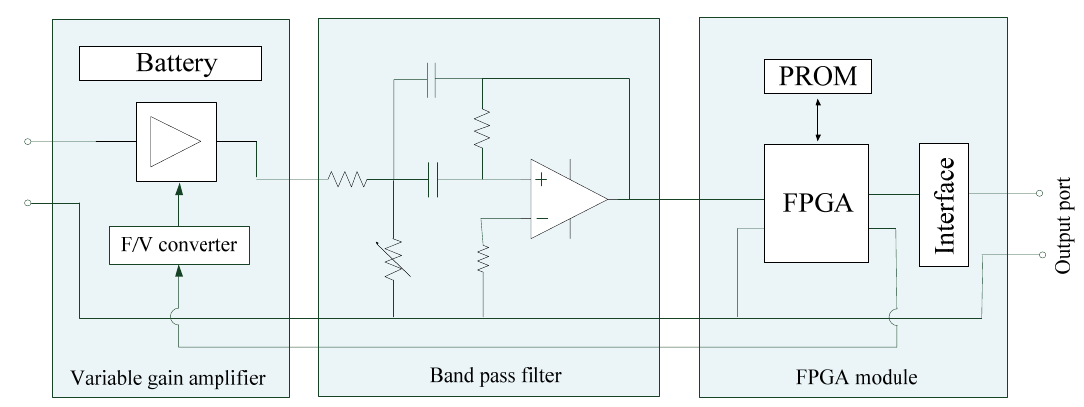
Figure 4. The structure of receiving